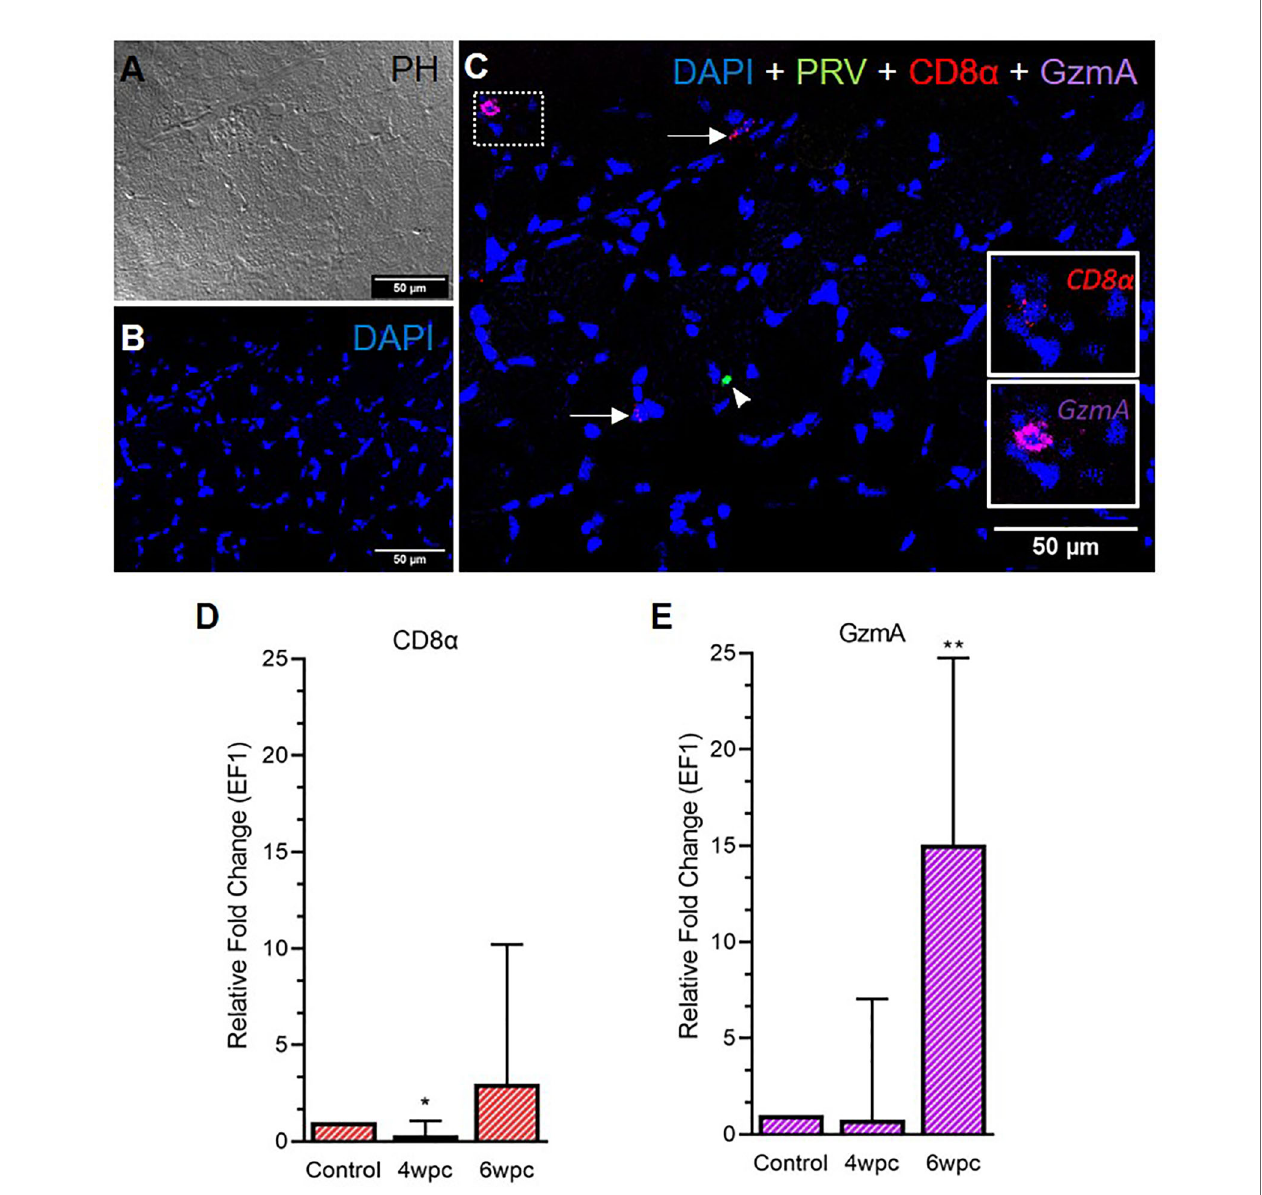
FIGURE 4 | Fluorescent in situ hybridization (FISH) of CD8 a , GzmA and PRV-1 in skeletal muscle at the peak of HSMI (6 wpc). (A) Phase contrast image showing structures of myocytes. (B) Nuclei stained with DAPI (Blue). (C) Merged image showing presence of PRV-1 (green) infected cell (arrowhead), and CD8+ cells (insets). Some cells were stained positive only for CD8 a and GzmA speci fi c transcripts (arrows) (Scale Bar = 50µm). (D, E) Relative fold expression (medians) of CD8 a and GzmA at 4 wpc and 6 wpc normalized against EF1 a . (*) shows signi fi cant difference from the control (*p < 0.05, **p <